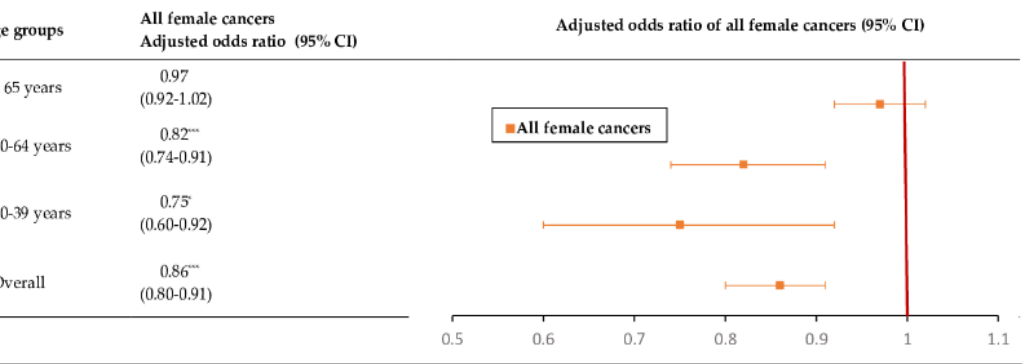
Figure 2. The association of PPI use with overall risk of all female cancers by age groups with adjusted odds ratios. CI, confidence interval. Footnote: * p < 0.05, *** p < 0.0001. 3.3. Associations of PPI Use with Breast, Cervical, Endometrial, and Ovarian Cancers